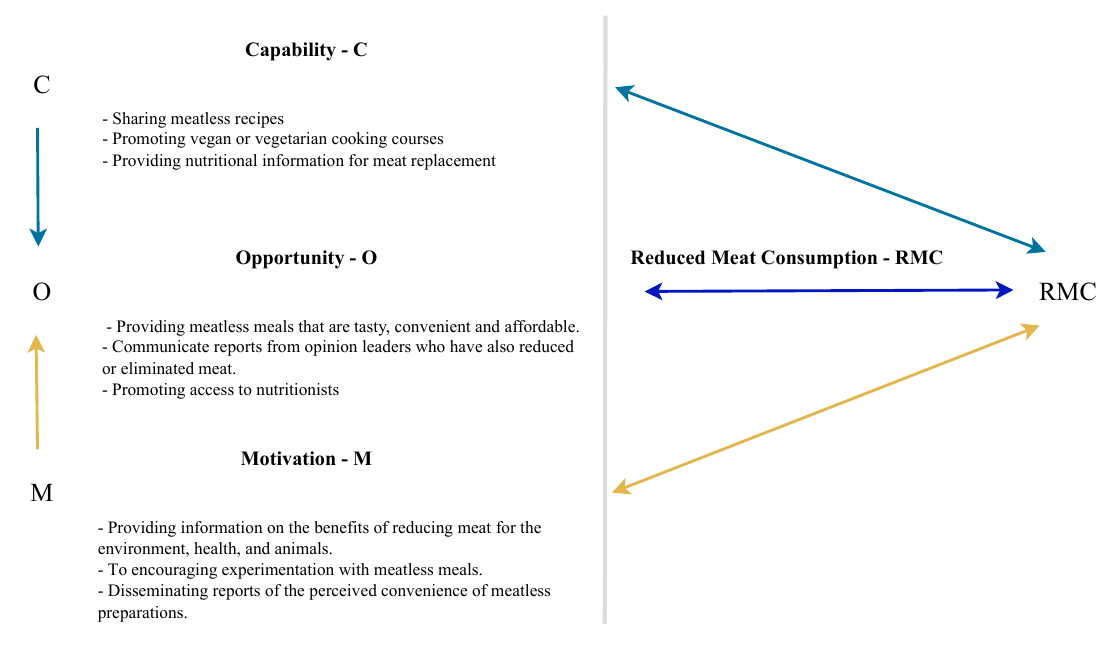
Figure 4. Proposed actions by external agents.